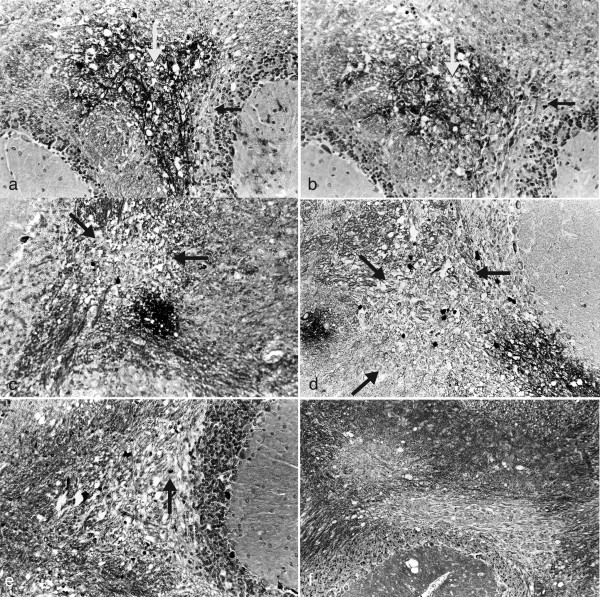
'Focal' areas of HSV-1 antigen positive cells and demyelinating lesions co-localize throughout the brains of SJL/J, A/J, and PL/J mice. Serial IHC sections counterstained with LFB-CFV were examined for 'focal' areas of viral antigen positive cells and CNS demyelination in the BST and CB. 'Focal' areas and demyelinating lesions co-localize throughout the brains of 10-12 week ♀ SJL/J, A/J, and PL/J mice infected with HSV-1 via the oral mucosa. Initially, island of demyelination are identified within or adjacent to 'focal' areas of viral antigen. Representative sections from the CB of PL/J mice identify these areas within (white arrow) or adjacent to (black arrow) 'focal' areas of viral antigen (a) 8 days PI (x200) and (b) 9 days PI (x200). As the 'focal' areas of viral antigen are cleared, the demyelinating lesions increase in size. Representative sections from the CB of SJL/J mice identify areas of demyelination (arrows) adjacent to 'focal' areas of viral antigen (c) 14 days PI (x200) and (d) 15 days PI (x200). Although individual antigen positive cells can remain in the demyelinating lesions for a period of time (e) antigen positive cell (arrow) in the CB of PL/J mouse, 18 days PI (x200), 'focal' areas of viral antigen are eventually cleared (f) demyelinating lesions in the CB of PL/J mouse, 20 days PI (x200).